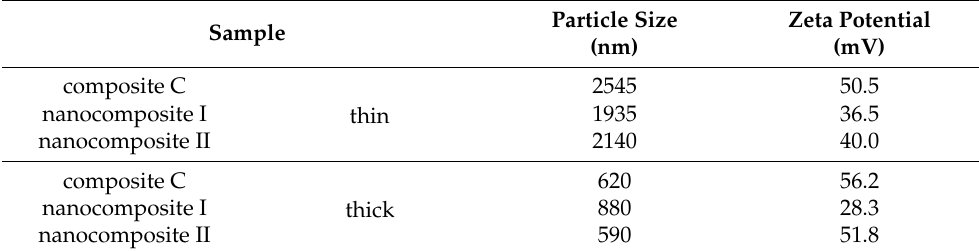
Table 1. Zeta potential and the particle size of composites.